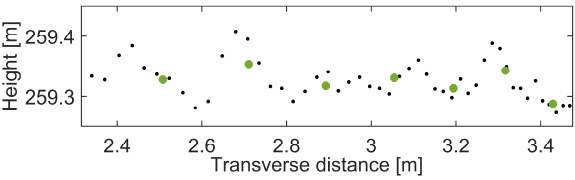
Figure 6: Cross section detail; green/black laser profiler points derived by averaging 100/15 echo